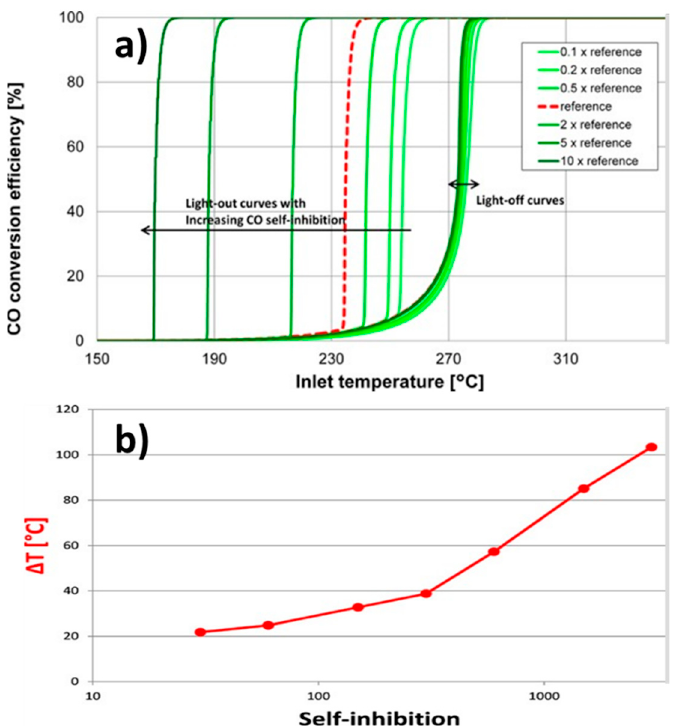
Figure 9. ( a ) Simulation results using different reaction and inhibition parameters. ( b ) Hysteresis magnitude as a function of self ‐ inhibition parameter [141].